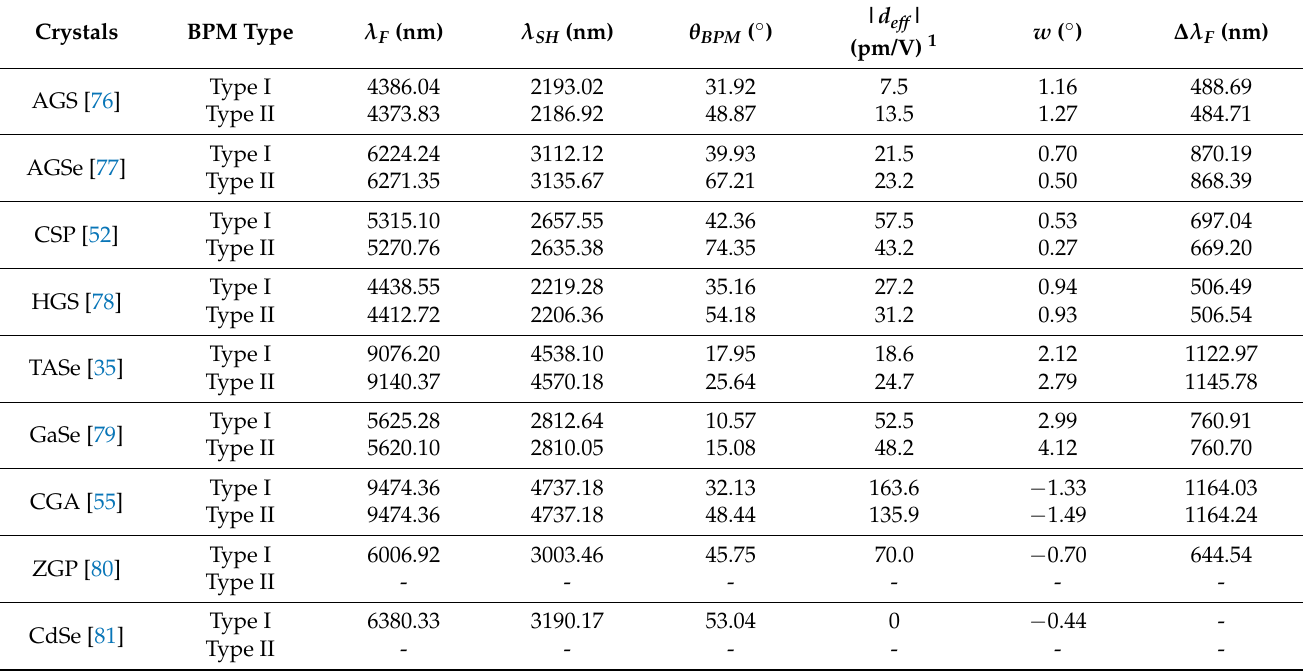
1 The tensor components ( d il ) used for the calculations are listed in Table 4.